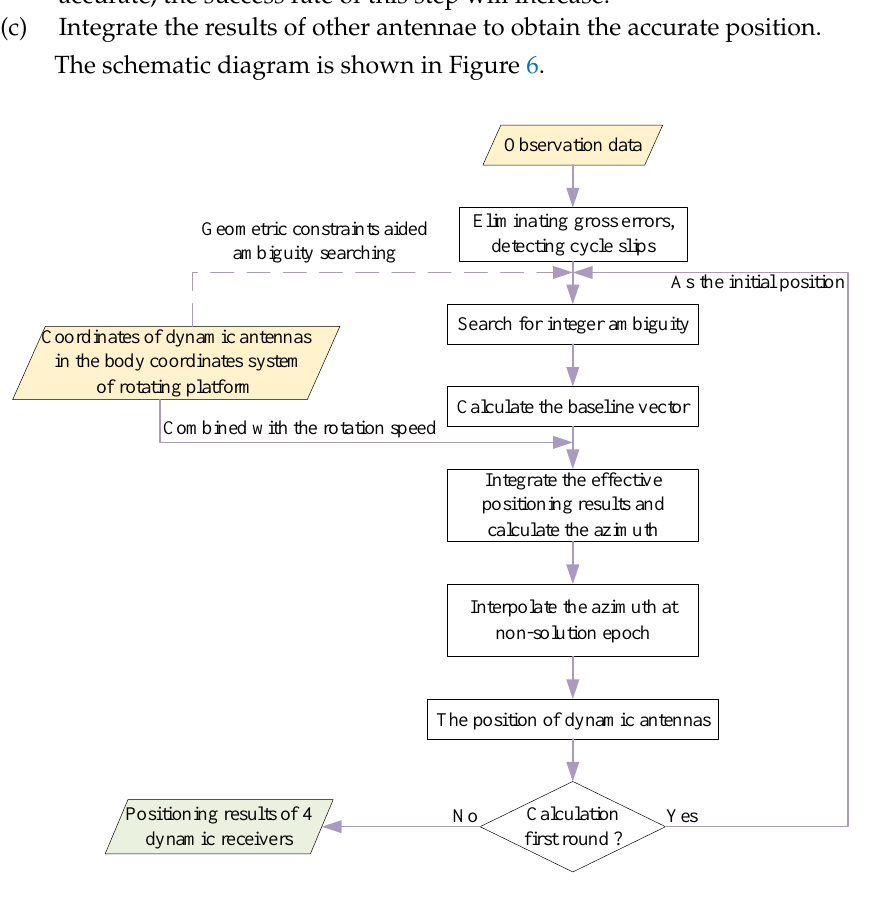
Figure 6. The method of improving the success rate of precise relative positioning.